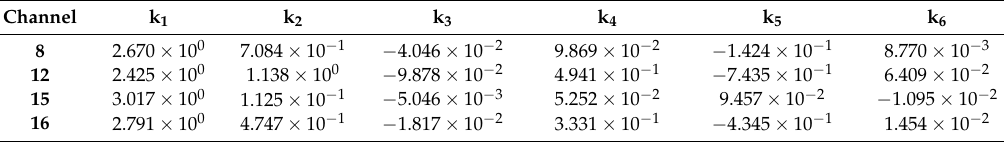
Table 5. The regression coefficient for each channel, used to convert narrowband radiance to narrowband irradiance.